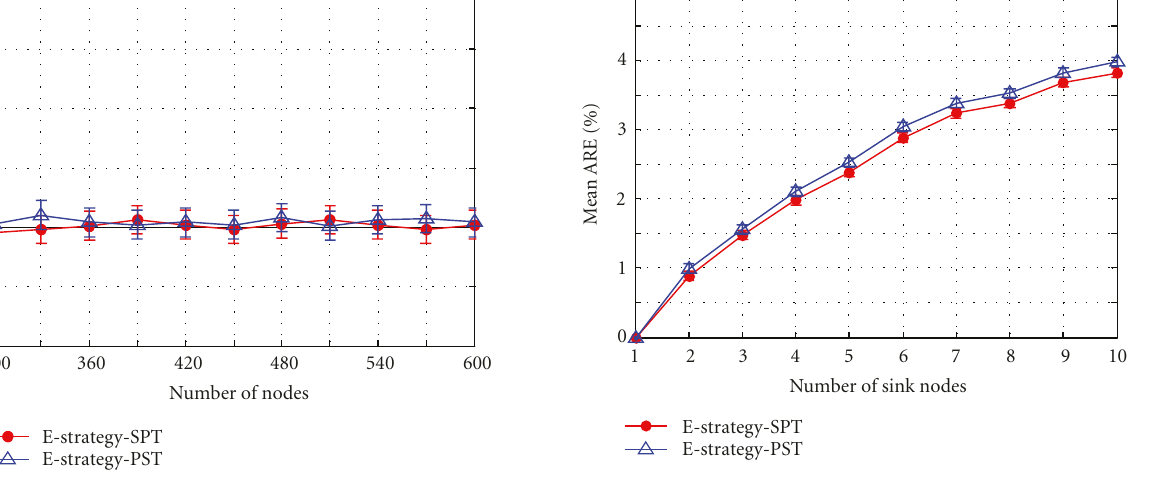
Figure 5: Accuracy versus node density.